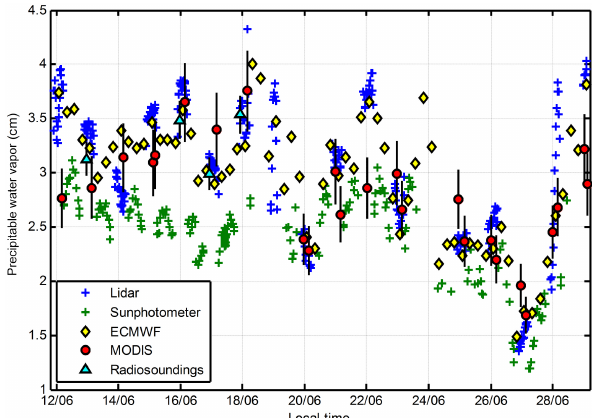
Figure 7. Comparison of various retrievals of integrated water vapour content (precipitable water vapour, PWV, in cm) from 12 to 19 June 2013: by lidar (blue), AERONET sun photometer (green), MODIS (average within a 10km radius area around the lidar, dis- carding cloudy pixels with lower PWV, red circles), ECMWF 0.5 ◦ model reanalyses (interpolation, yellow diamonds) and radiosound- ings at Menorca (cyan triangles, error bars computed after uncer- tainty in Table 1) as a reference. Error bars given for MODIS repre- sent 10% relative error (Pérez-Ramirez et al.,